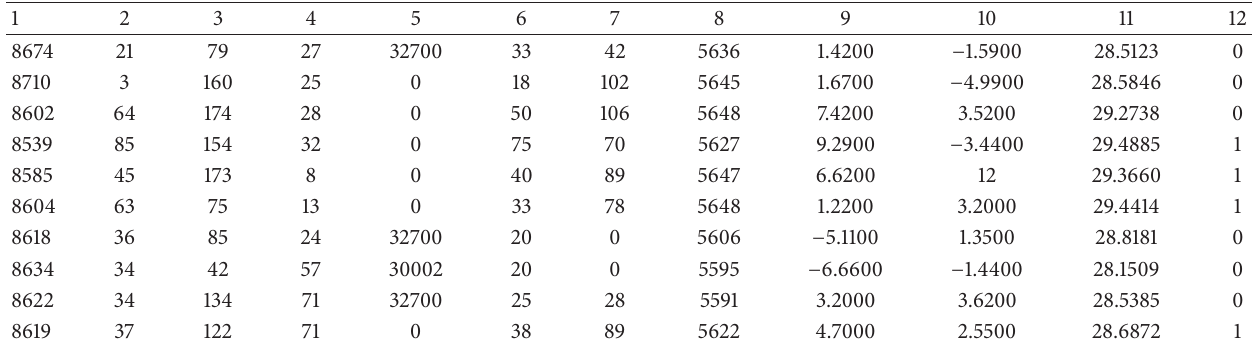
Table 2: Sample data set.